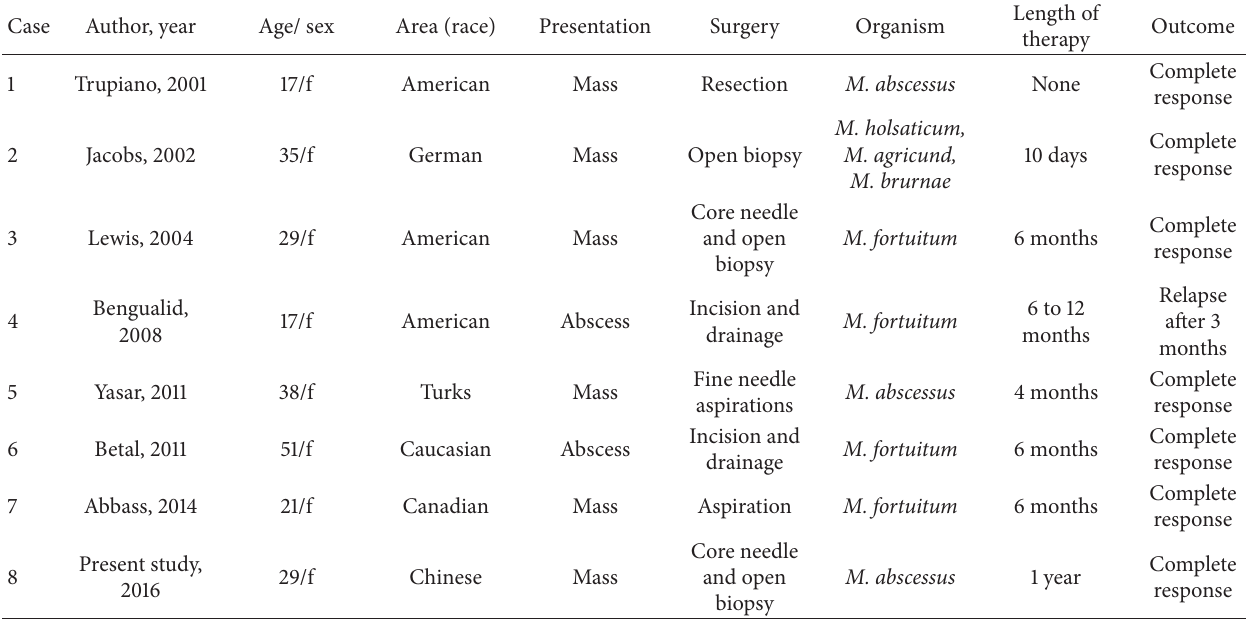
Table 1: Cases of breast infection caused by Mycobacteria reported in the